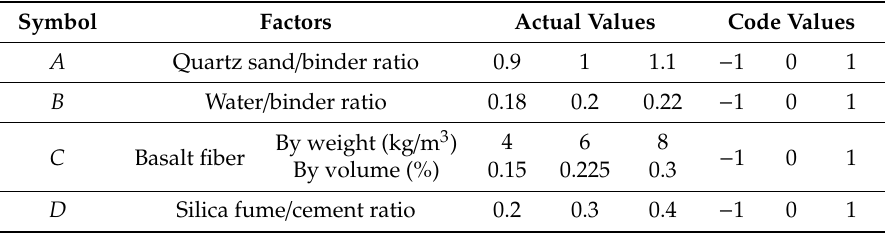
Table 5. Levels of experimental factors, given in actual and code values.